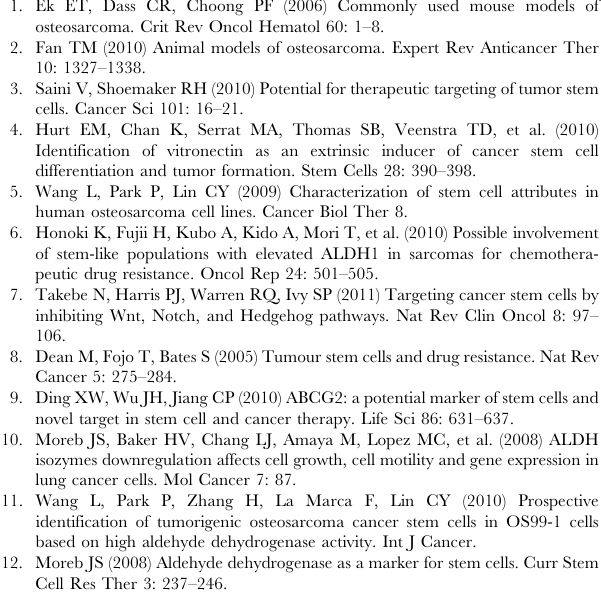
(TIF) Figure S4 ABCA5 expression in CHA59, Saos-2, and HuO9 monolayers and spheres measured by microarray analysis ( A ) or real-time RT-PCR ( B, C ) . *p , 0.05. (TIF) Figure S5 Bioinformatics analysis of ABC transporter expression in CHA59 and Saos-2. (A) CHA59 and Saos-2 monolayer and sphere ABC transporter immunophenotype grouped into 10 clusters. (B) Different distribution of populations in triple positive and single positive clusters in CHA59 and Saos-2 monolayers and spheres. (C) Principal Component Analysis distinguishes between CHA59 and Saos-2 cell, and between monolayers and spheres. (TIF) Figure S6 Allelic distribution in the 16 target loci tested by STR analysis of CHA59, Saos-2, and HuO9 cell lines. (TIF) Figure S7 Antibody details for flow cytometry and/or FACS.